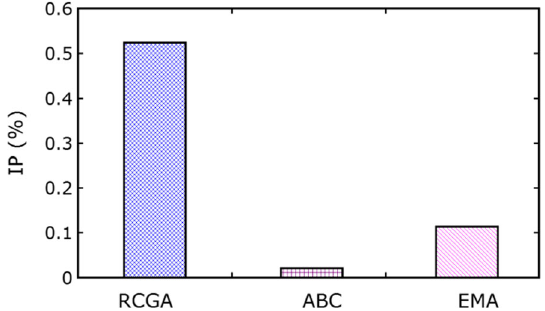
Fig. 10 Comparison of IPs obtained by various approaches for scenario 3